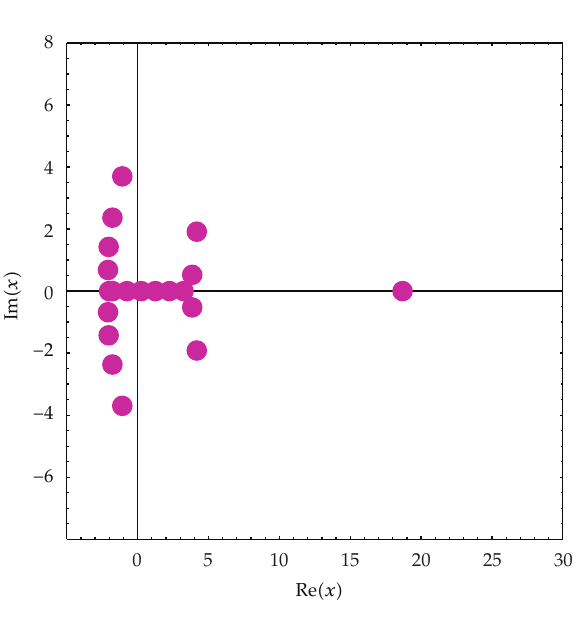
Figure 7: Zero of G 20 , 1 / 3 (cid:2) x (cid:3)